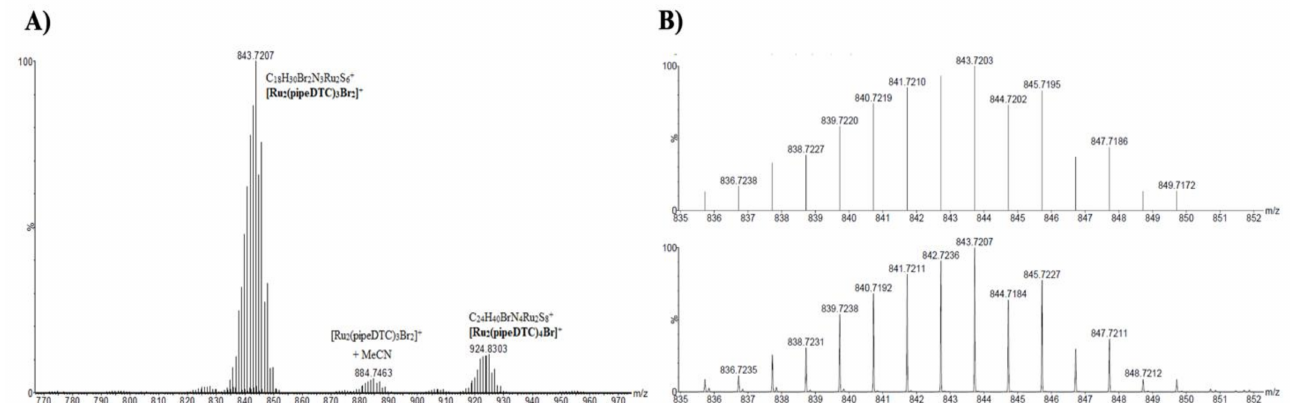
Figure 3. (A)ESI-MS spectra of the product obtained by oxidation of [Ru(II)(pipeDTC) 2 (NBD)] with Br 2 . The parent peak at m / z : 843.7207 ([Ru 2 (III)(pipeDTC) 3 Br 2 ] + ) is accompanied by a peak ( m / z : 884.7463) due to the adduct with the solvent (+MeCN). At m / z : 924.8303 a signal relative to [Ru 2 (III)(pipeDTC) 4 Br] + is also found. ( B ) Simulated peak pattern (above) vs. experimental peak pattern (below) for the product of oxidation of [Ru(II)(pipeDTC) 2 (NBD)] with Br 2 (oxidized bimetallic precursor [Ru 2 (III)(pipeDTC) 3 Br 2 ] + ). The presence of two ruthenium atoms and two bromine atoms implies a characteristic isotopic peak